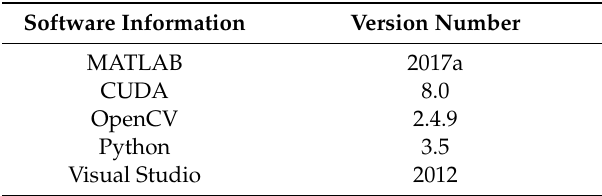
Table 1. Software information in the